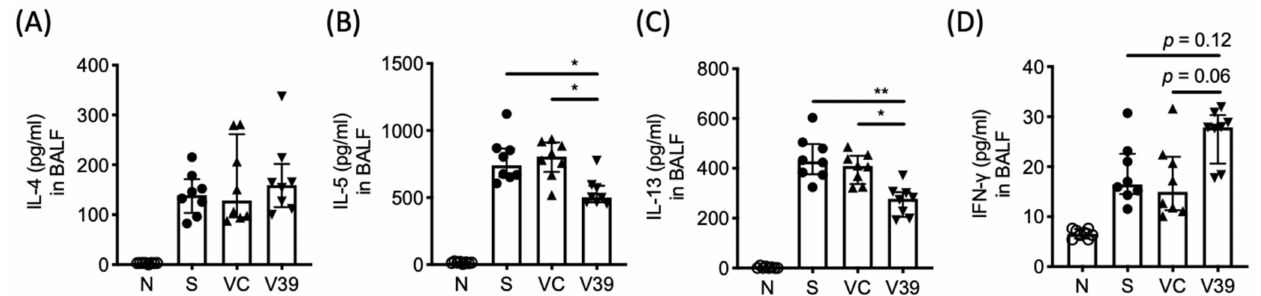
Figure 4. The levels of Th2 cytokines were downregulated in BALF with exogenous expression of CD39. After the last OVA exposure, the lungs were lavaged and the concentration of ( A ) IL-4, ( B ) IL-5, ( C ) IL-13, and ( D ) IFN- γ in BALF were determined by ProcartaPlex. Data are presented as median with interquartile range (* p < 0.05, ** p < 0.01 in the comparison of V39 with S or VC).